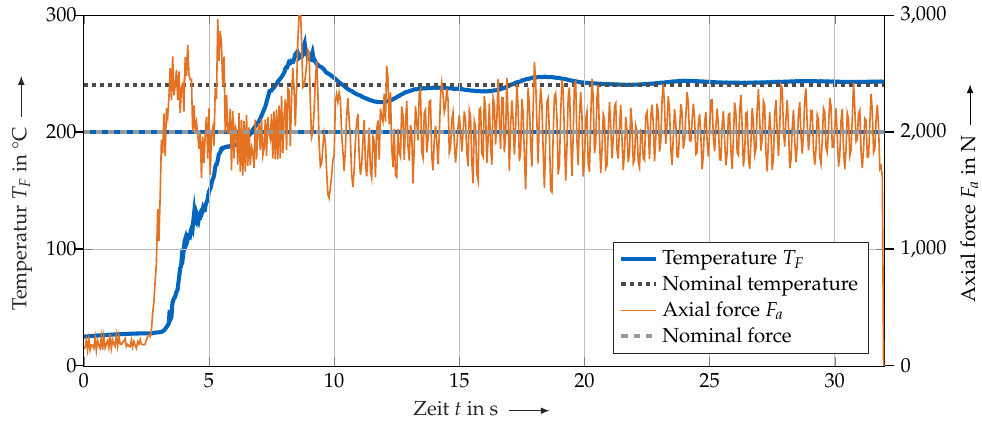
Figure 7. Temperature and force responses of the complete joining process regulated by the extended MPC with F aset = 2000N, v = 450mmmin − 1 , and T Fset =